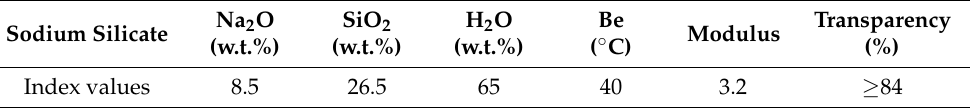
Table 3. Mass composition of sodium